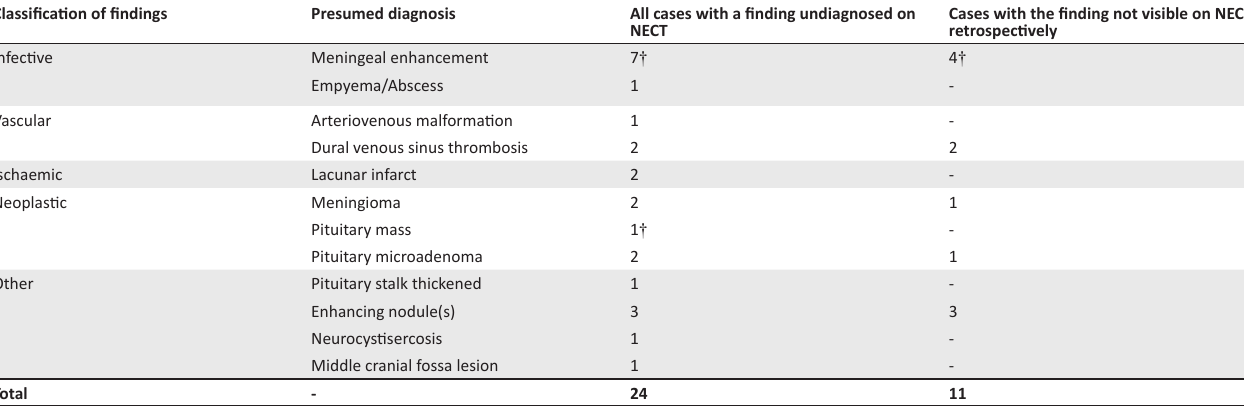
TABLE 2: Summary of findings undiagnosed on NECT. Classification of